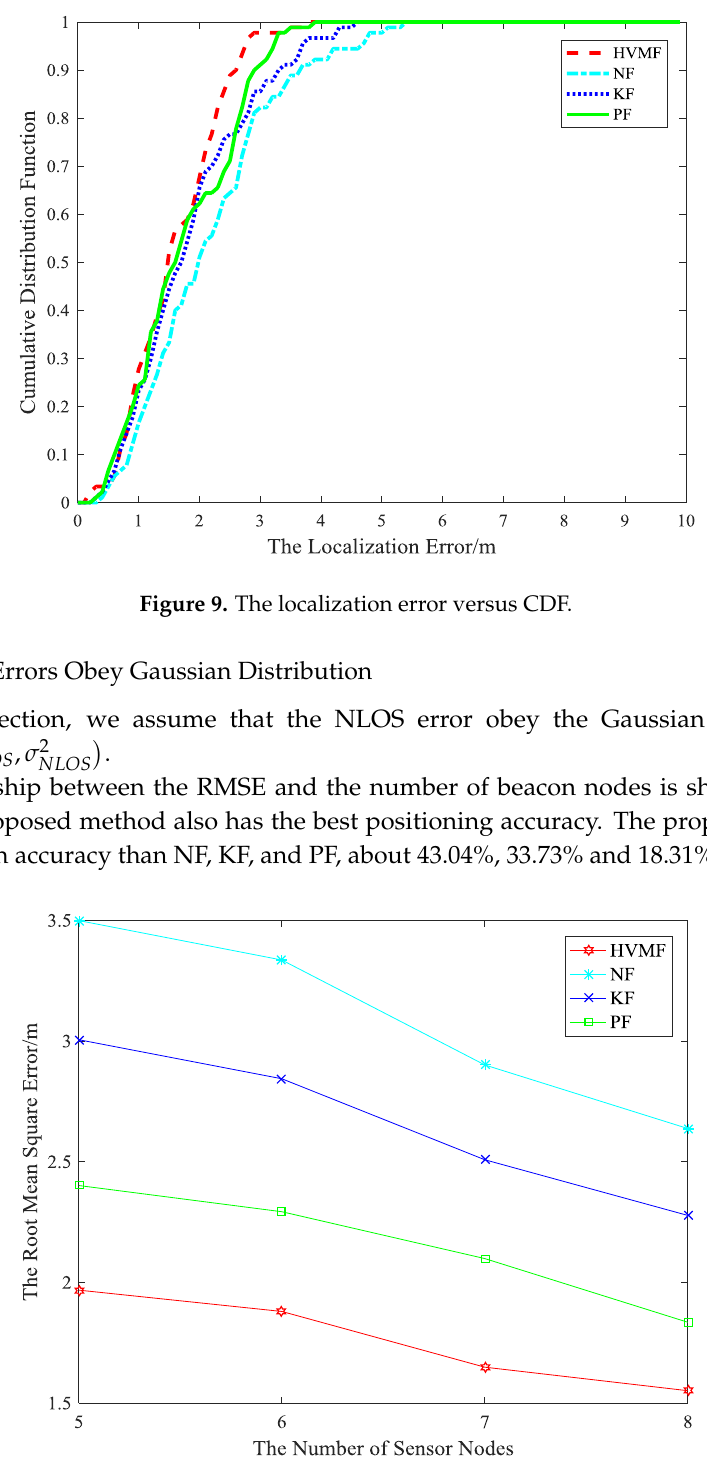
Figure 10. The number of beacon nodes versus Root Mean Square Error (RMSE).